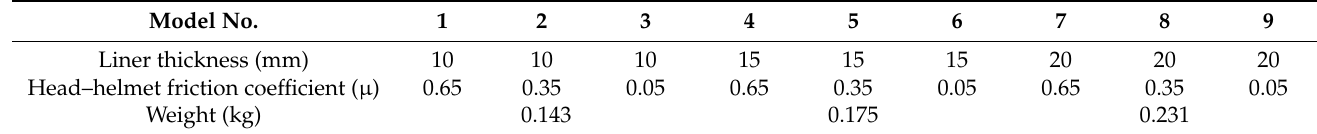
Table 2. Model setup to generate training